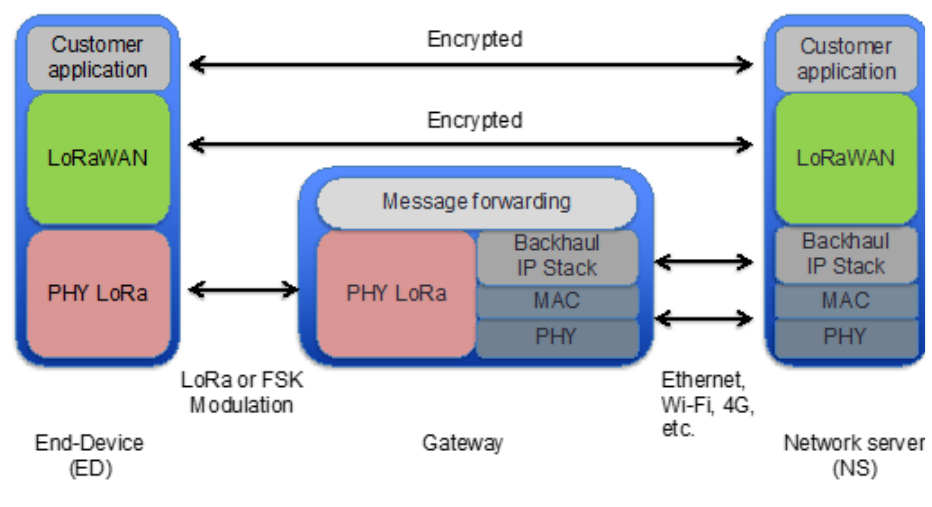
Figure 1. LoRaWAN protocol stack for each network